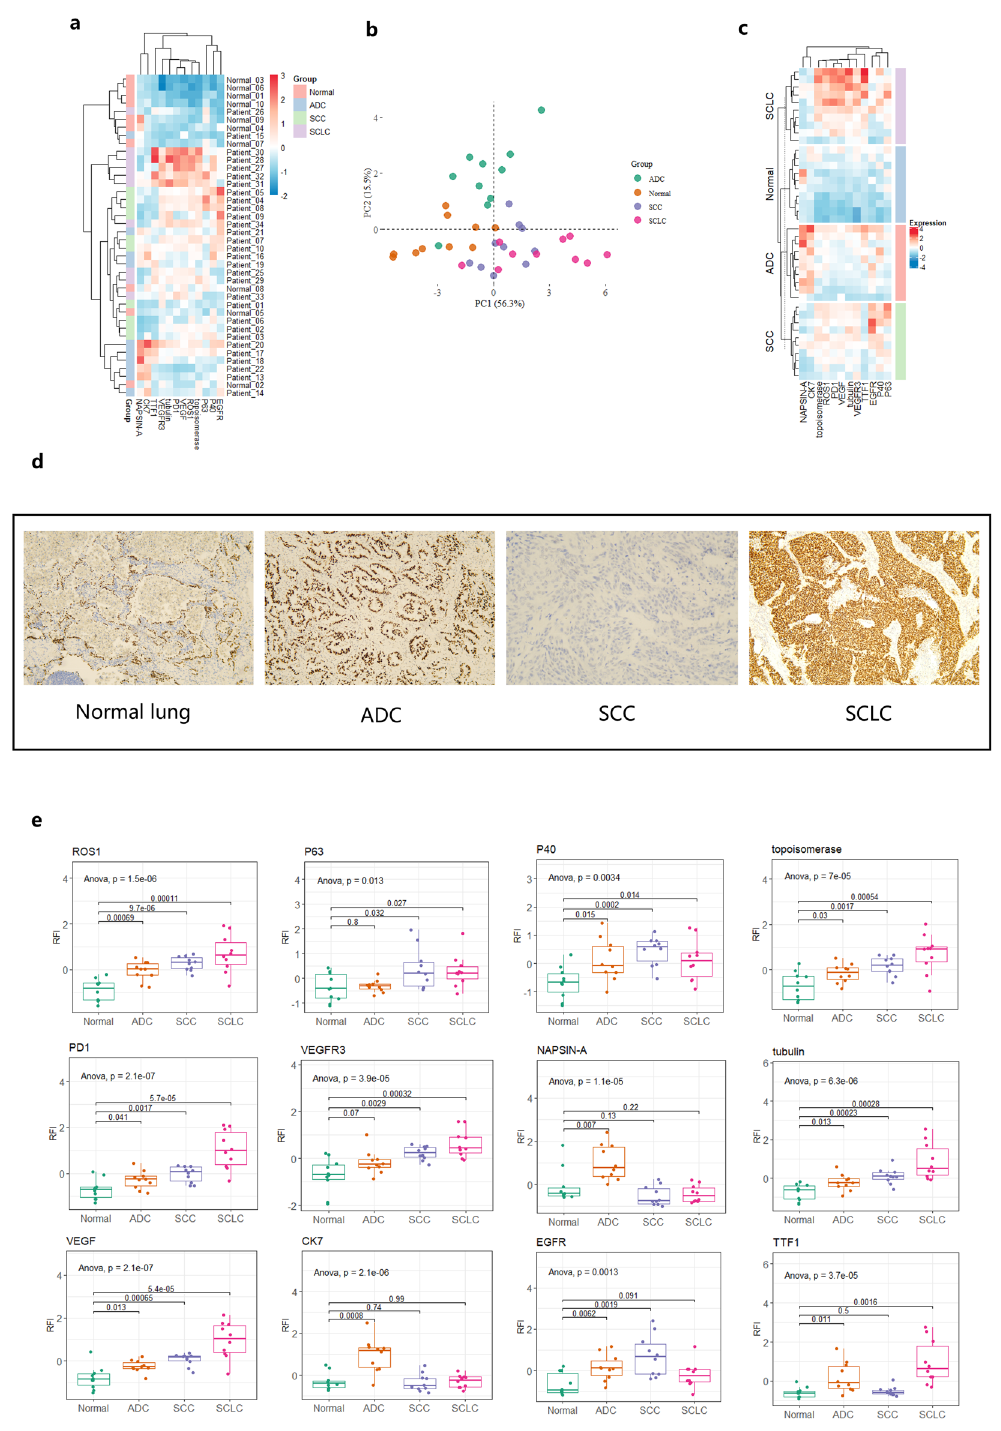
Figure 6. Clustering analysis based on 12-protein based RPPA profiling of lung cancer patient subtypes. ( a ) Unsupervised hierarchical clustering of three lung cancer subtypes (adenocarcinoma ADC, squamous cell carcinoma SCC, small cell lung cancer SCLC) and para-tumor FFPE samples. ( b ) PCA plot of three lung cancer subtypes and normal lung tissues and only PC1 and PC2 are presented. ( c ) Clusteing heatmaps grouped by individual subtypes. ( d ) Immunohistochemistry staining of TTF1 across three lung cancer subtypes and adjacent normal tissues. Images were taken at ×100 resolution. ( e ) Boxplots of individual protein expression shown by RFI in three lung cancer subtypes. Adenocarcinoma ADC, squamous cell carcinoma SCC, small cell lung cancer SCLC and para-tumor FFPE samples are compared and statistical test results are shown